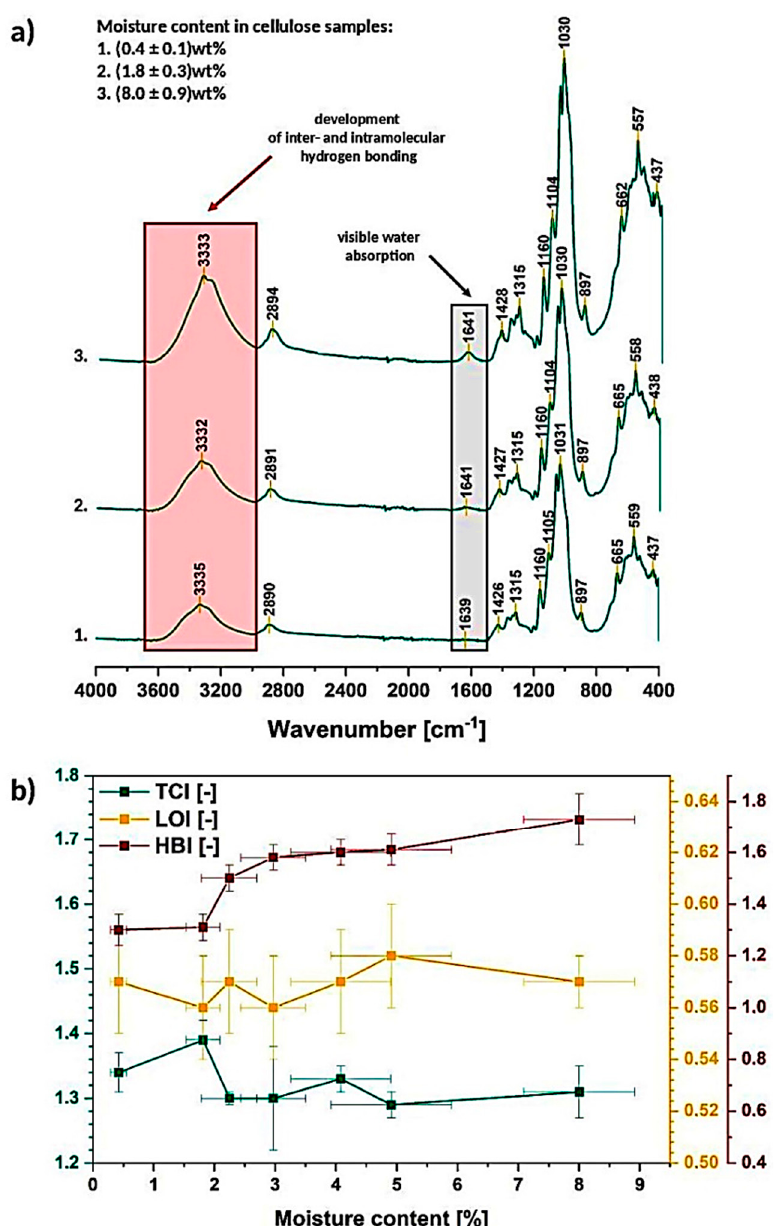
Figure 4. Exemplary Fourier-transformation infrared spectra of cellulose of different moisture content ( a ) and graph illustrating changes in TCI, LOI, HBI as a function of moisture content ( b ).